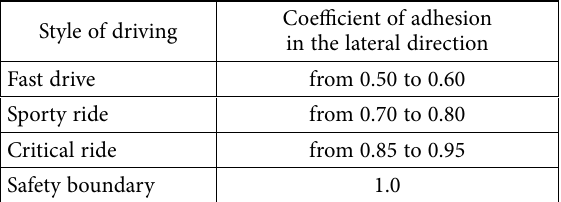
Table. The available values of the adhesion coefficient in the lateral direction according to driving style of the Volvo V40 T5 AWD Cross Country vehicle equipped with the driving dynamics stabilization system (Panáček